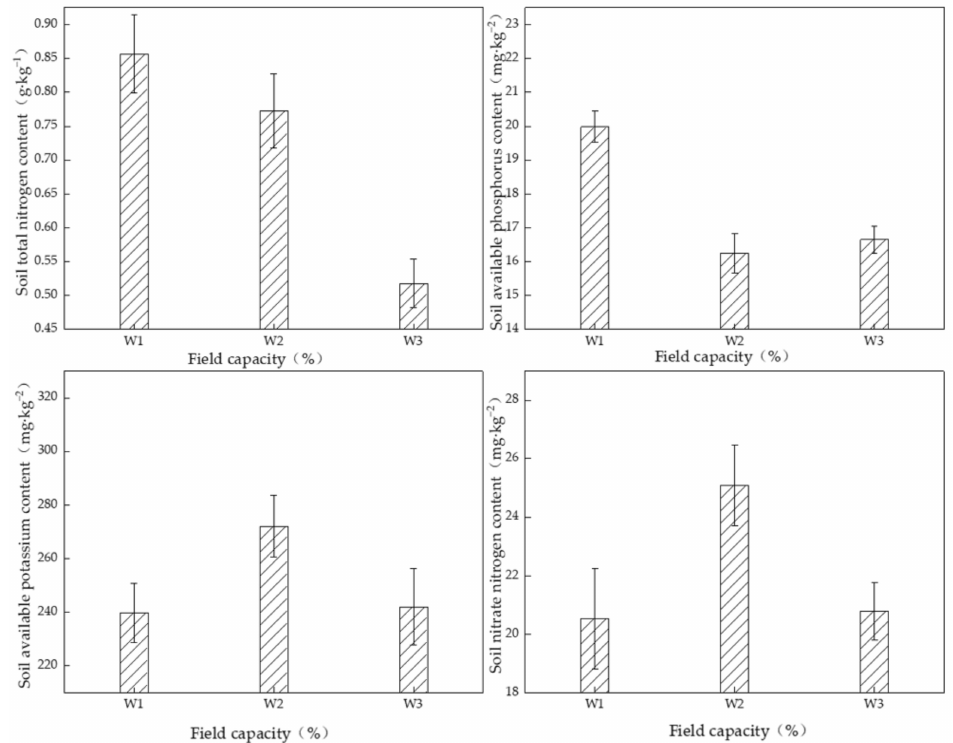
Figure 3. Effects of different field capacities on soil nutrient content in Populus tomentosa forestland.